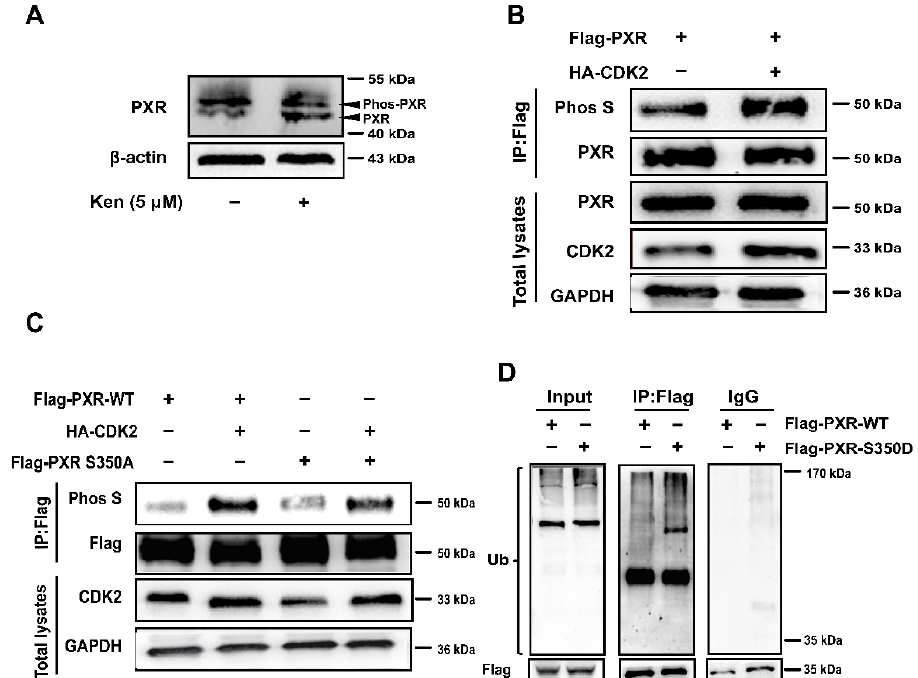
Figure 6. PXR phosphorylation at S350 by CDK2 triggers PXR degradation via ubiquitin-proteasome pathway. ( A ) HepG2 cells were treated with kenpaullone (5 μ M) for 24 h. Cytoplasmic fractions (30 μ g each) were subjected to Phos-tag SDS-PAGE, and the levels of phosphorylated PXR and non- phosphorylated PXR were analyzed. ( B ) HEK 293T cells were transfected with full-length Flag-PXR with or without the co-transfection of HA-CDK2. Cell lysates were immunoprecipitated with anti- Flag and immunoblotted with anti-phos serine. ( C ) HEK 293T cells were transfected with Flag-PXR or Flag-PXR-S350A (Ser350A) with or without the co-transfection of HA-CDK2. Cell lysates were immunoprecipitated with anti-Flag antibody, then immunoblotted with anti-phos serine antibody. ( D ) HEK 293T cells were co-transfected with HA-ubiquitin and Flag-PXR (WT) or Flag-PXR-S350D (Ser350D). After 24 h, cells were treated with 5 μ M MG-132 for 24 h. Ubiquitination of WT-PXR or Ser350D-PXR was measured by IP-immunoblotting. Experiments described in this figure were re- peated independently at least three times.